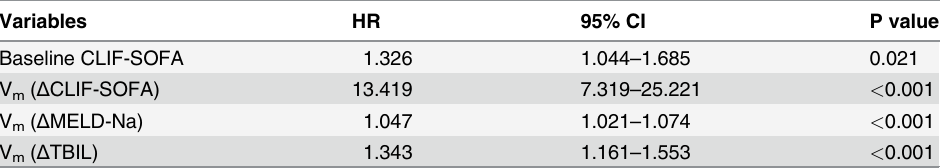
Table 4. Multivariate Cox regression analysis of independent predictors associated with progression into post-enrollment EASL-CLIF ACLF from ACLF at enrollment de fi ned by APASL alone or by both APASL and CMA but not by EASL-CLIF